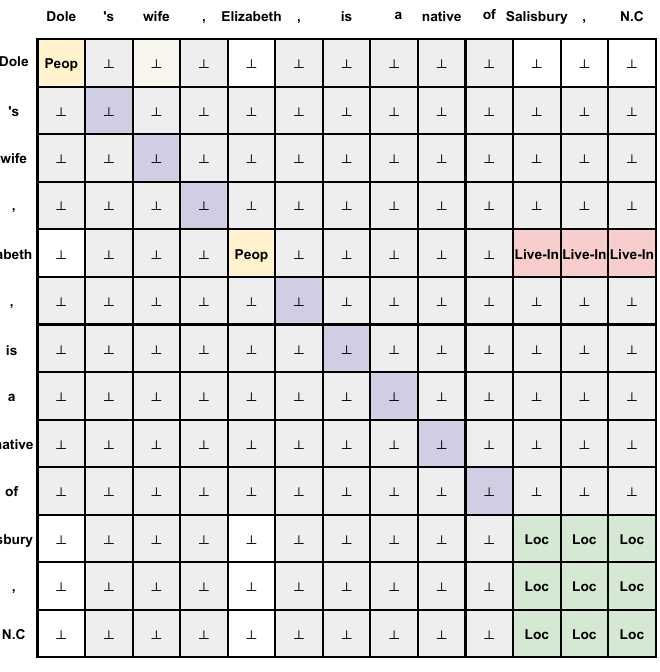
Figure 1. Table for joint entity and relation extraction. Each cell in the table corresponds to a word pair, the square part on the main diagonal is the entity, and the rectangular part on the off-diagonal is the relation. Any label is produced by averaging the pooling of the encoder